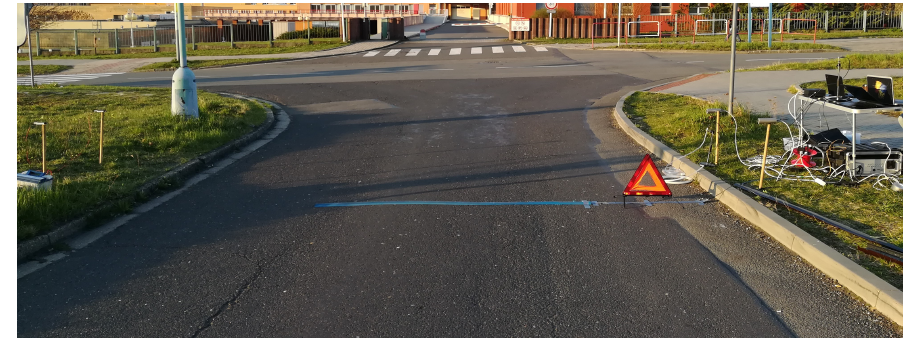
Figure 8. Measuring station at the entrance to the VSB-TUO